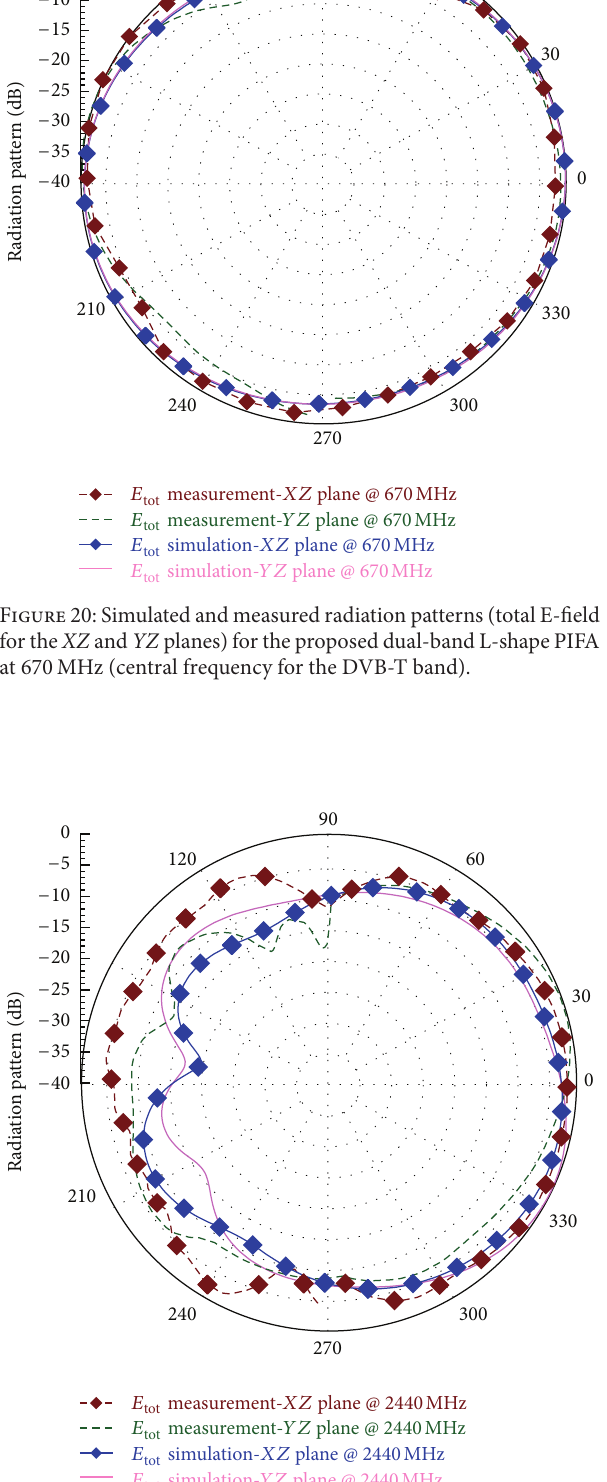
Figure 21: Simulated and measured radiation patterns (total E-field for the XZ and YZ planes) for the proposed dual-band L-shape PIFA at 2440 MHz (central frequency for the IEEE 802.11b,g